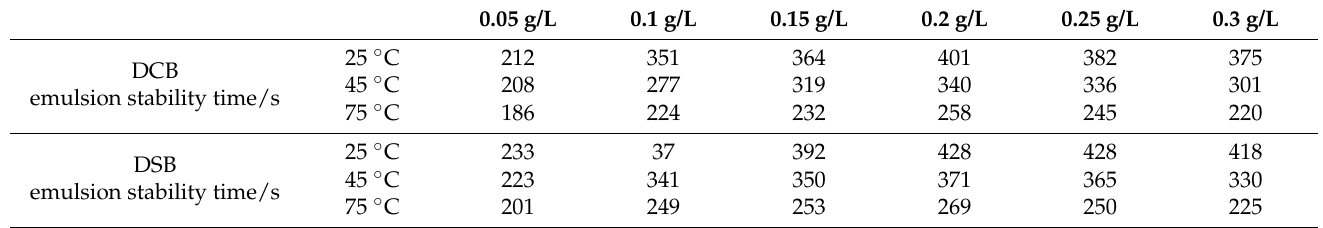
Table 2. Emulsification time of DCB and DSB at different concentrations and